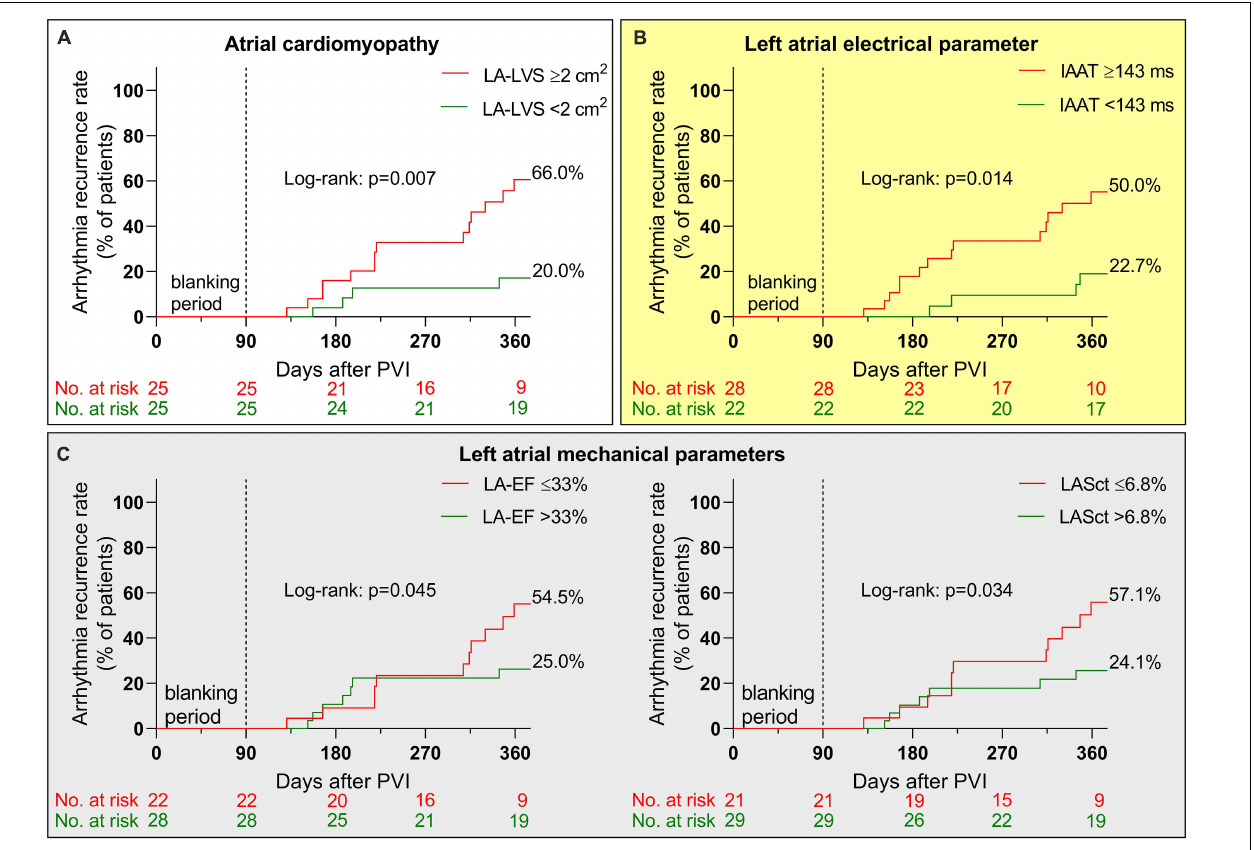
FIGURE 5 | Arrhythmia recurrence after pulmonary vein isolation (PVI). Kaplan–Meier curves illustrate arrhythmia recurrence after PVI in patients with relevant atrial cardiomyopathy [ACM defined as ≥ 2 cm 2 left atrial low-voltage substrate (LA-LVS) extent at 0.5 mV threshold, red curve in A ], prolonged left atrial electrical conduction parameters [invasive atrial activation time (IAAT), red curve in B ] and impaired left atrial mechanical parameters [left atrial emptying fraction (LA-EF) and left atrial strain during contraction phase (LASct), red curves in C ] compared to patients with normal cut-offs (green